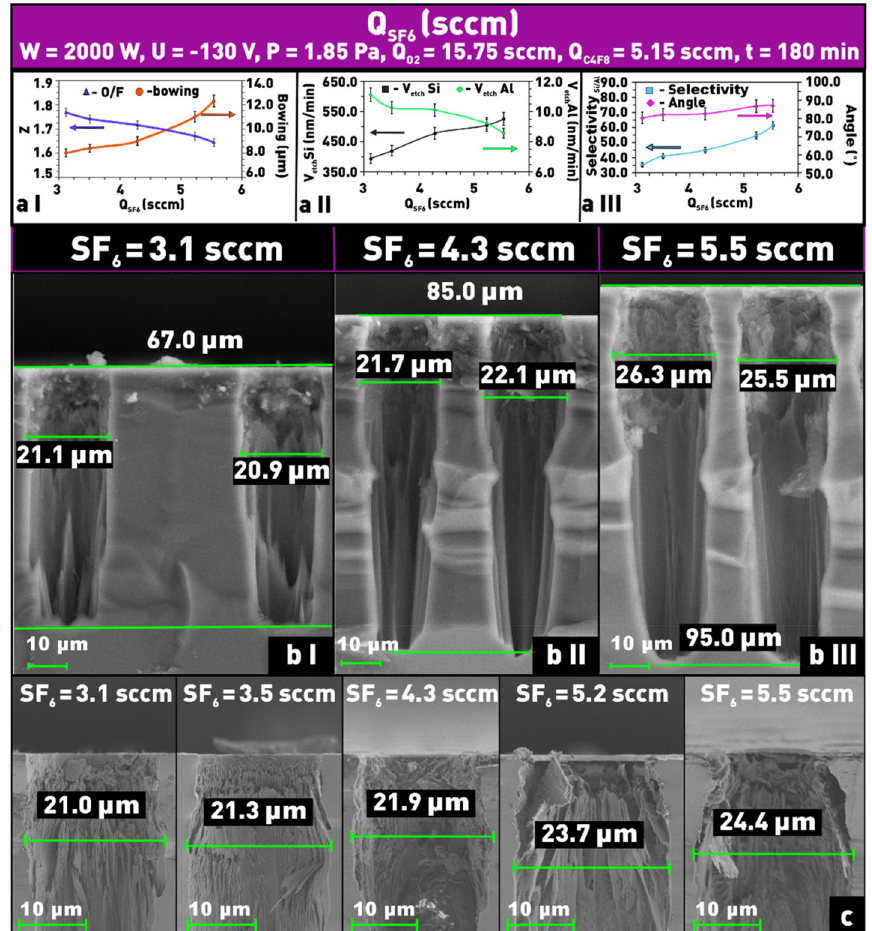
Figure 5. Dependences on SF 6 flow rate in SF 6 /C 4 F 8 /O 2 plasma: ( a I ) of δ and Z; ( a II ) of etching rates of silicon and aluminum; ( a III ) of etch selectivity and angle Θ; ( b I–III ) microphotographs of etched windows profiles at different contents of SF 6 in SF 6 /C 4 F 8 /O 2 plasma; ( c ) microphotographs of etched windows at different contents of SF 6 in SF 6 /C 4 F 8 /O 2 plasma to evaluate the structure overetching